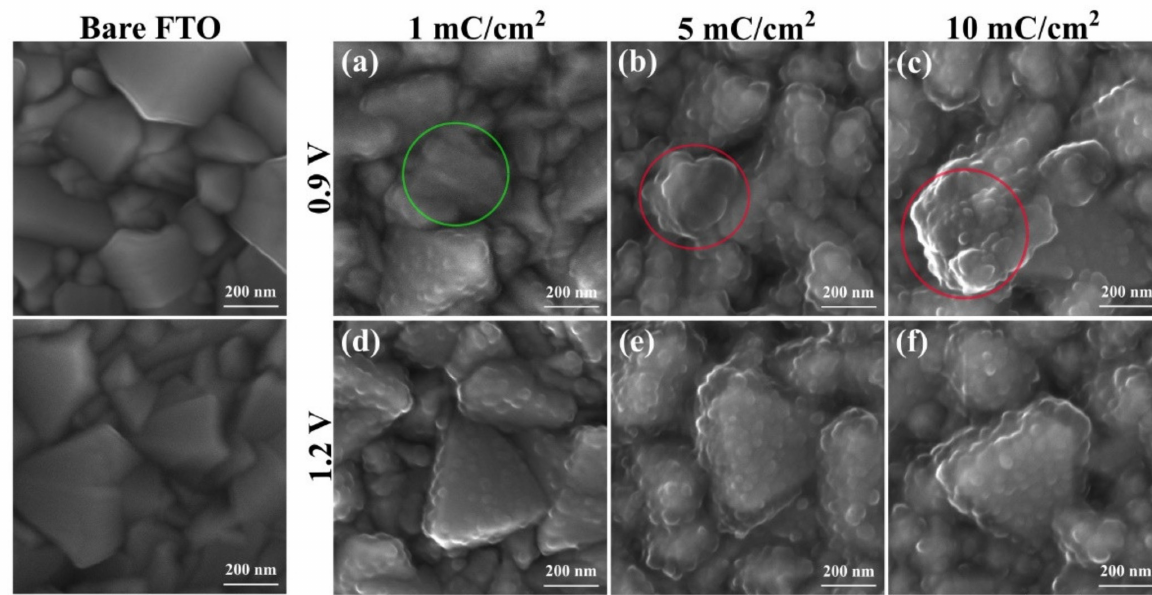
Figure 3. SEM images of PPy synthesized on FTO with electric charge control (mC/cm 2 ). ( a – c ): polymerization at 0.9 V vs. Ag/AgCl; ( d – f ): polymerization at 1.2 V vs.